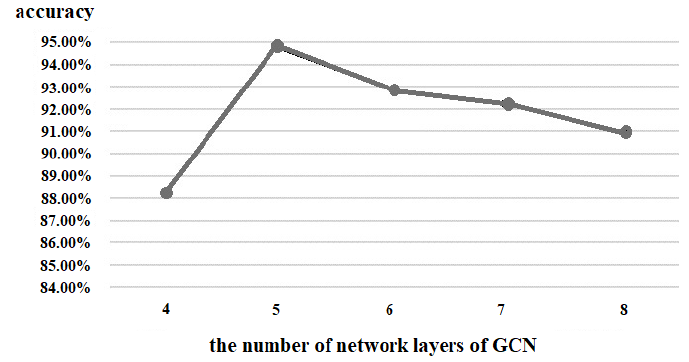
Figure 11. Comparison of the number of network layers of GCN.